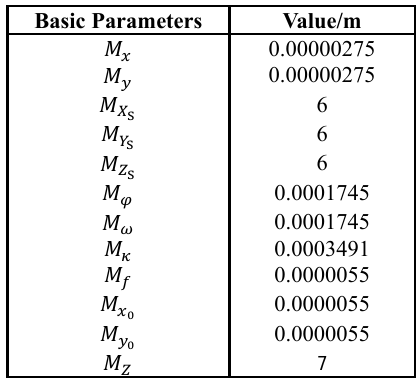
Table 2. The MSE of Basic Parameters. The positioning MSE at different flight heights and different whiskbroom angles are calculated based on values in Tab. 2 according to formula (15). Tab. 3 shows the results of positioning errors at 4000m altitude and different whiskbroom angles, where 𝑀 𝑋 is the positioning direction, and 𝑀 𝑋𝑌 is the plane MSE, the value comparison at different whiskbroom angle is in Fig.3. Fig.4 is a comparison diagram of 𝑀 𝑋𝑌 at different altitudes under various